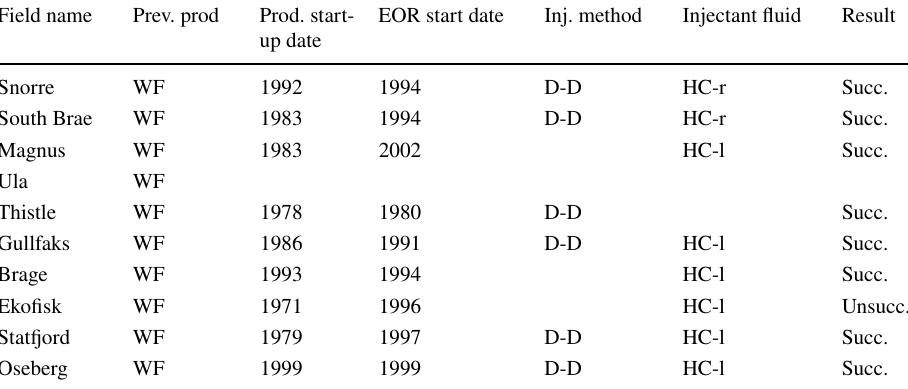
Table 2 WAG schemes in the North Sea from 1975 to 2005. Reproduced with permission from Awan et al. (2008)